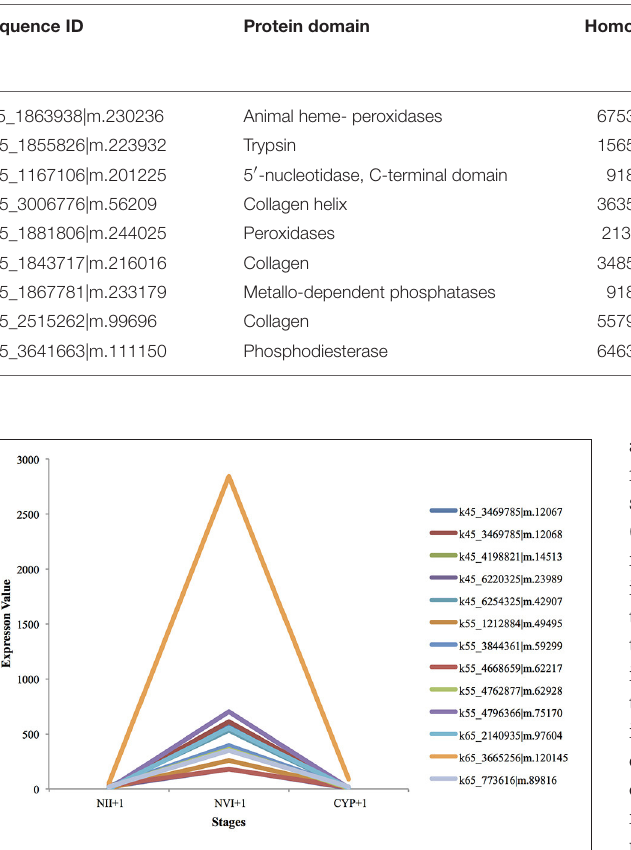
FIGURE 4 | UP-regulated genes from Nauplius II to Nauplius VI following by down regulation in Cyprid.